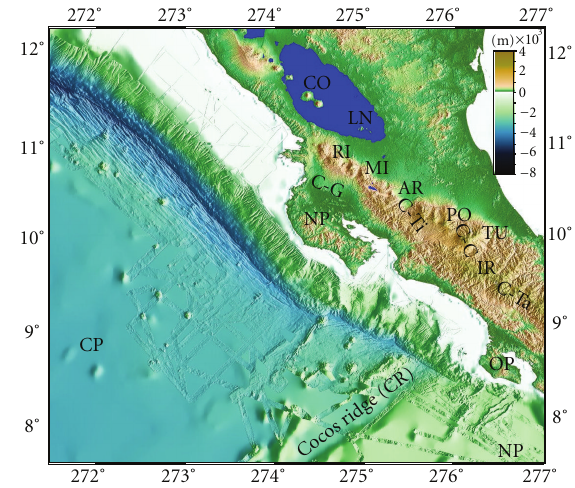
Figure 5: Overview map of the research area. The SRTM3 topographic dataset [28] and partly high-resolution bathymetry collected by the SFB 574 are combined. The high-resolution bathy- metric data point to the dynamics of the tectonic environments and complex ocean floor bathymetry (Ranero et al. [33, 37]). The dataset was compiled from several cruises and is owned by the IfM-Geomar and the SFB 574. Some abbreviations also used in following figures are introduced: Lago Nicaragua (LN) with the Concepci´on volcano (CO) in Nicaragua, Nicoya Peninsula (NP), and Osa Peninsula (OP), both in Costa Rica, now from north to south: Rinc´on de la Vieja (RI) and Miravalles (MI) on the Cordillera Guanacaste (C-G); Arenal (AR) on the Cordillera Tilar´an (C-Ti); Po´as (PO), Iraz´u (IR), and Turrialba (TU) on the Cordillera Central (C-C) and finally the Cordillera de Talamanca (C-Ta). The Cocos Ridge (CR) collides with Central America in the southwest. (CP) stands for Cocos plate and (NP) for Nazca plate.